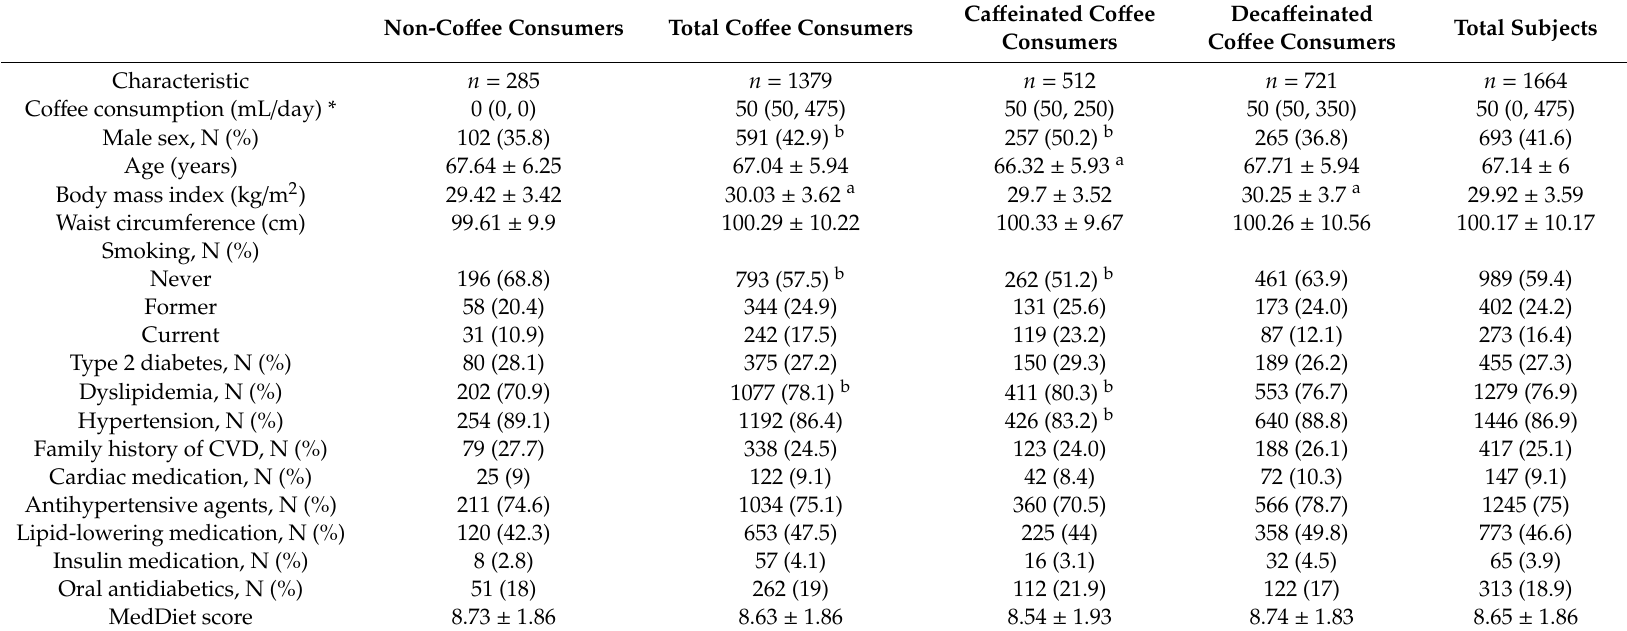
Table 1. Characteristics of the study subjects according to co ff ee and types of